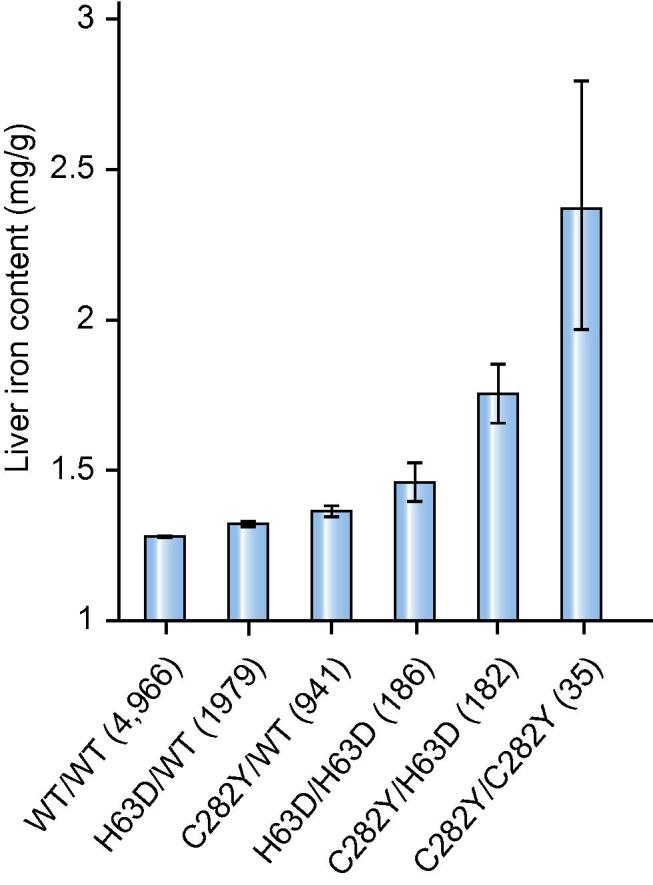
Liver iron content per genotype group. The x-axis represents the 6 genotype groups based on the number of C282Y and H63D they carry. The y-axis represents the mean of liver iron (mg/g) per category. Error bars indicate 95% CIs. Numbers in brackets are the number of individuals per genotype category. WT, wild-type.